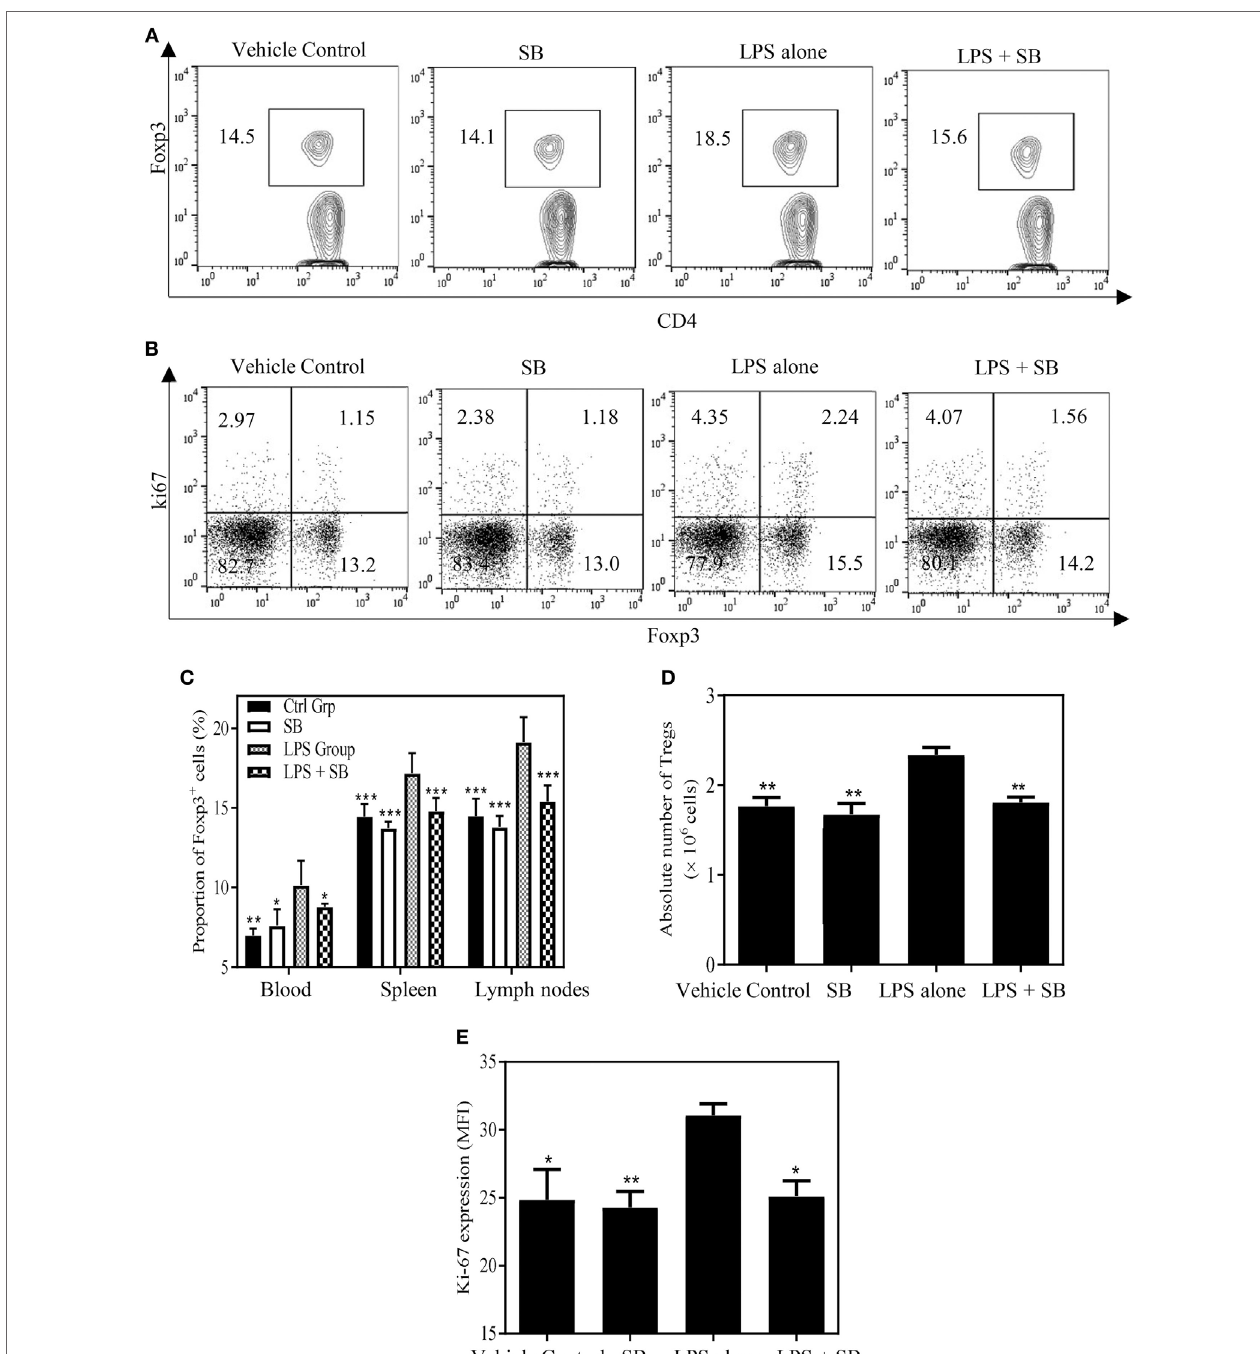
FigUre 5 | SB203580 inhibits expansion of regulatory T cells (Tregs) in LPS-treated mice. C57BL/6J mice were injected with 200 µg of LPS (i.p.) or PBS, and treated with or without SB203580 (25 mg/kg/day, i.p.) immediately after LPS challenge. All mice were sacrificed 24 h after LPS treatment. Blood, spleen, and lymph nodes were harvested. The proportion of Foxp3 + Tregs in CD4 + T cells and expression of Ki-67 by Tregs were analyzed by FACS, gating on Foxp3 + cells. The absolute number of Tregs was calculated. (a) Expression of Foxp3 by CD4 + T cells. Number shows the proportion of gated cells. (B) Expression of Ki-67 by Foxp3 − and Foxp3 + cells. Number shows the proportion of positive cells in the respective quadrants. (a,B) Typical FACS plots were shown. (c) Summary of proportion of Tregs in CD4 + T cells in the peripheral blood, spleen and LNs. (D) Summary of absolute number of Tregs in the spleen. (e) Ki-67 expression (MFI) by Foxp3 + Tregs. Data [means ± SEM) in (c) were pooled from three separate experiments (spleen and lymph nodes: N = 9, peripheral blood: N = 6), and in (D,e) ( N = 3) were representatives of at least three separate experiments with similar results. By comparison with LPS alone group, * p < 0.05, ** p < 0.01, *** p <